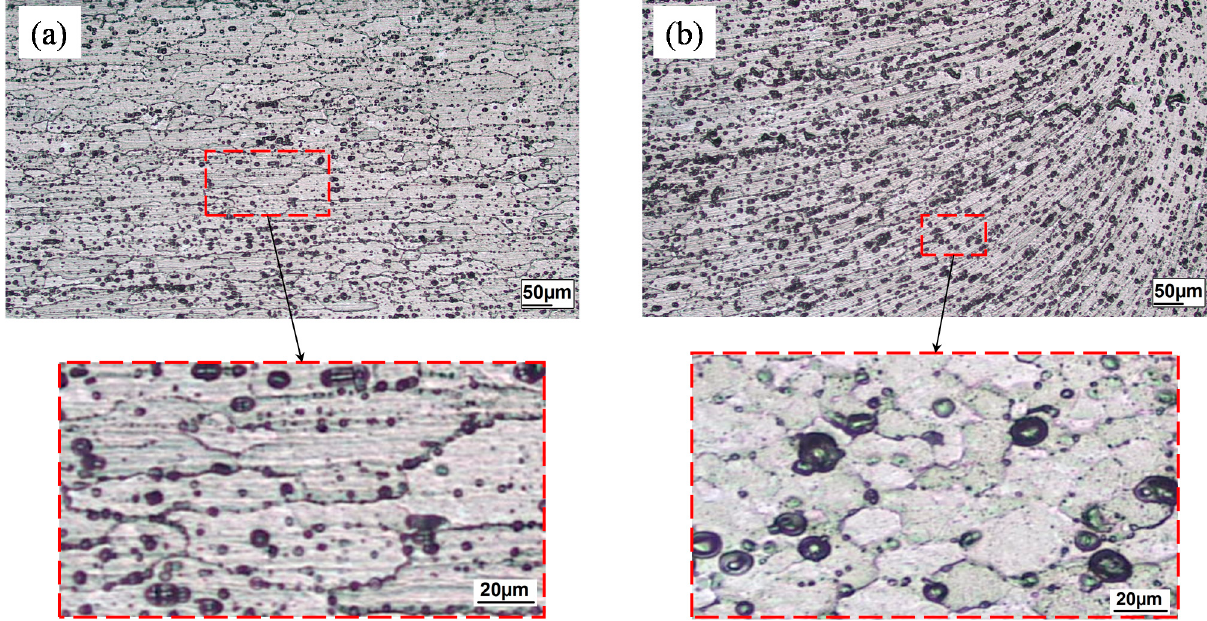
Figure 9. Microstructures of the HAZ for: ( a ) the as-welded joint; ( b ) the STA heat-treated joint.